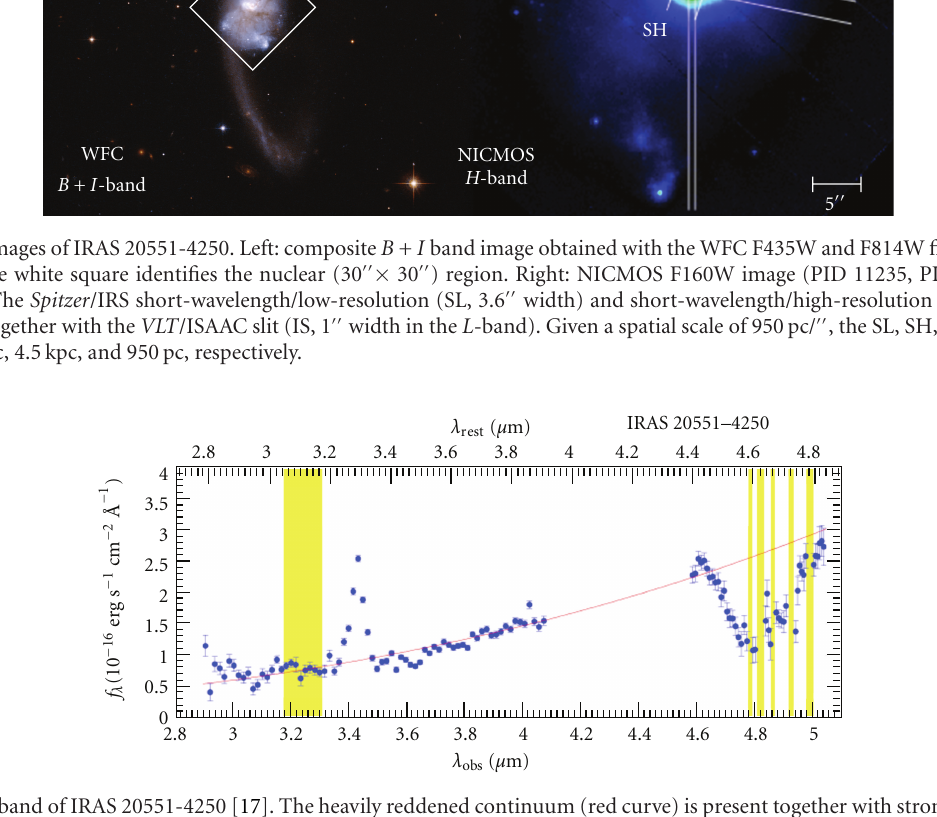
among ULIRGs. The implications on the shape of the extin- ction law are discussed in the following